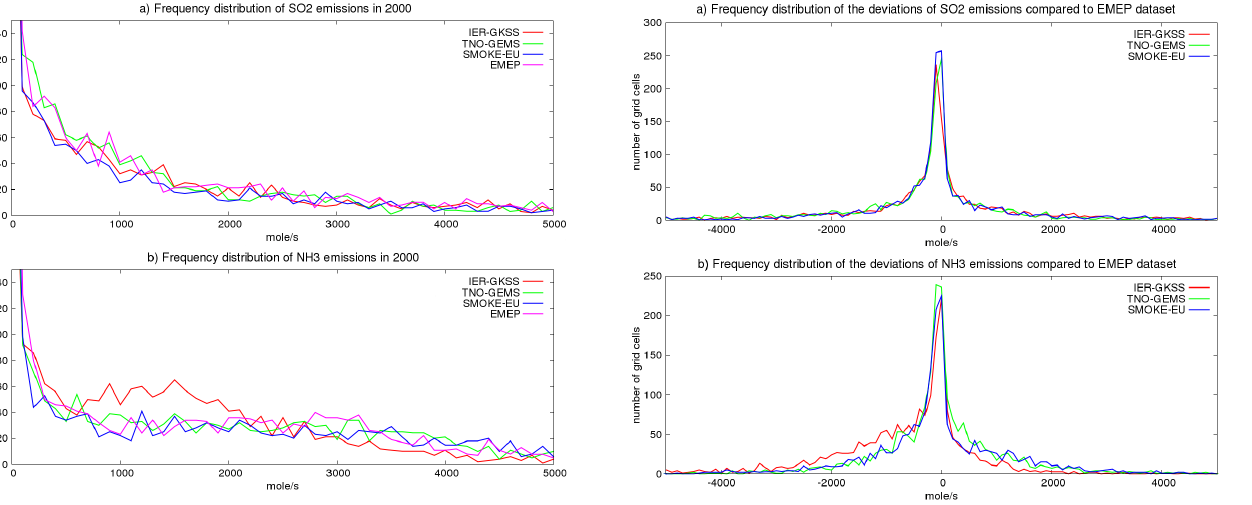
Fig. 7. Frequency distribution of different emission datasets for the year 2000 on a 54 × 54km 2 domain (Fig. 2). (a) SO 2 emissions (b) NH 3 emissions.